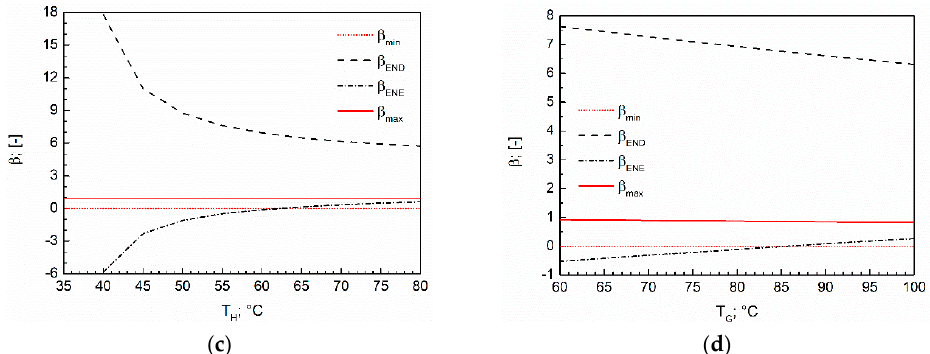
Figure 5. Thermo-chemical performance index values as a function of the ( a ) evaporation, ( b ) absorption, ( c ) condensation, and ( d ) generator temperatures in order to obtain a better performance of an absorption machine in comparison with a machine with a mechanical compressor.